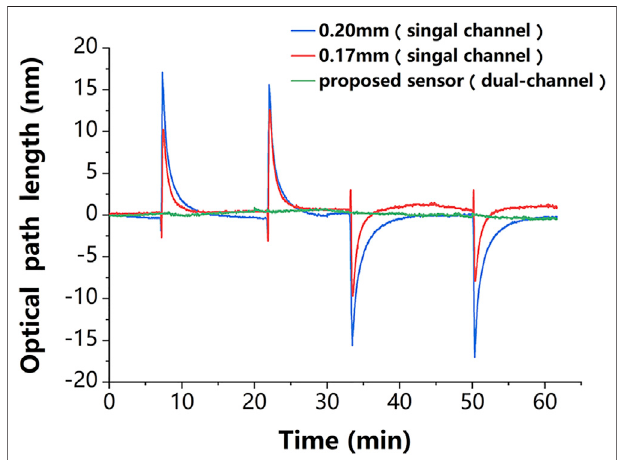
FIGURE 4 | Experimental results. The thickness variation of the chips in the single-channel sensor (red and blue lines) is very consistent with temperature variation in Figure 3C , which proves that this sensing chip is sensitive to the temperature disturbance. The phase change of the proposed dual-channel sensor (green line) is about one-tenth of that of the single-channel sensor, which proves that it is less sensitive to temperature disturbance.